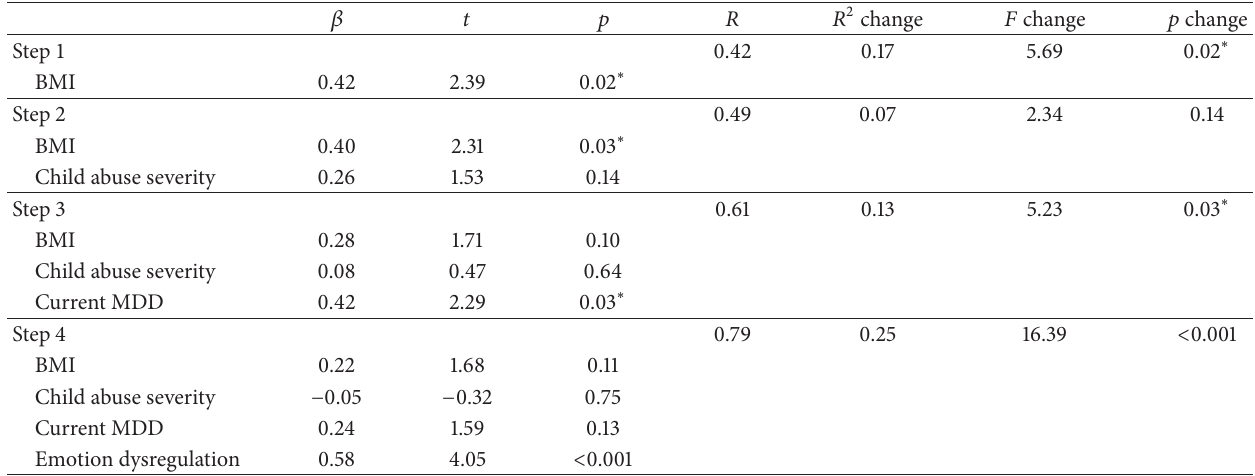
Table 3: Linear regression model predicting current hsCRP levels from trauma exposure, current MDD diagnosis, and overall emotion dysregulation